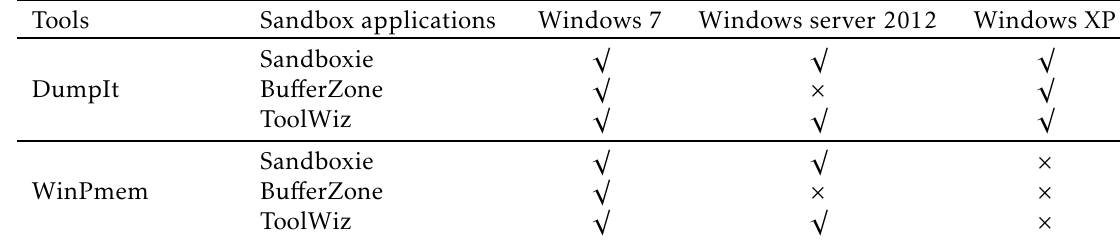
Table 6. Acquisition process status